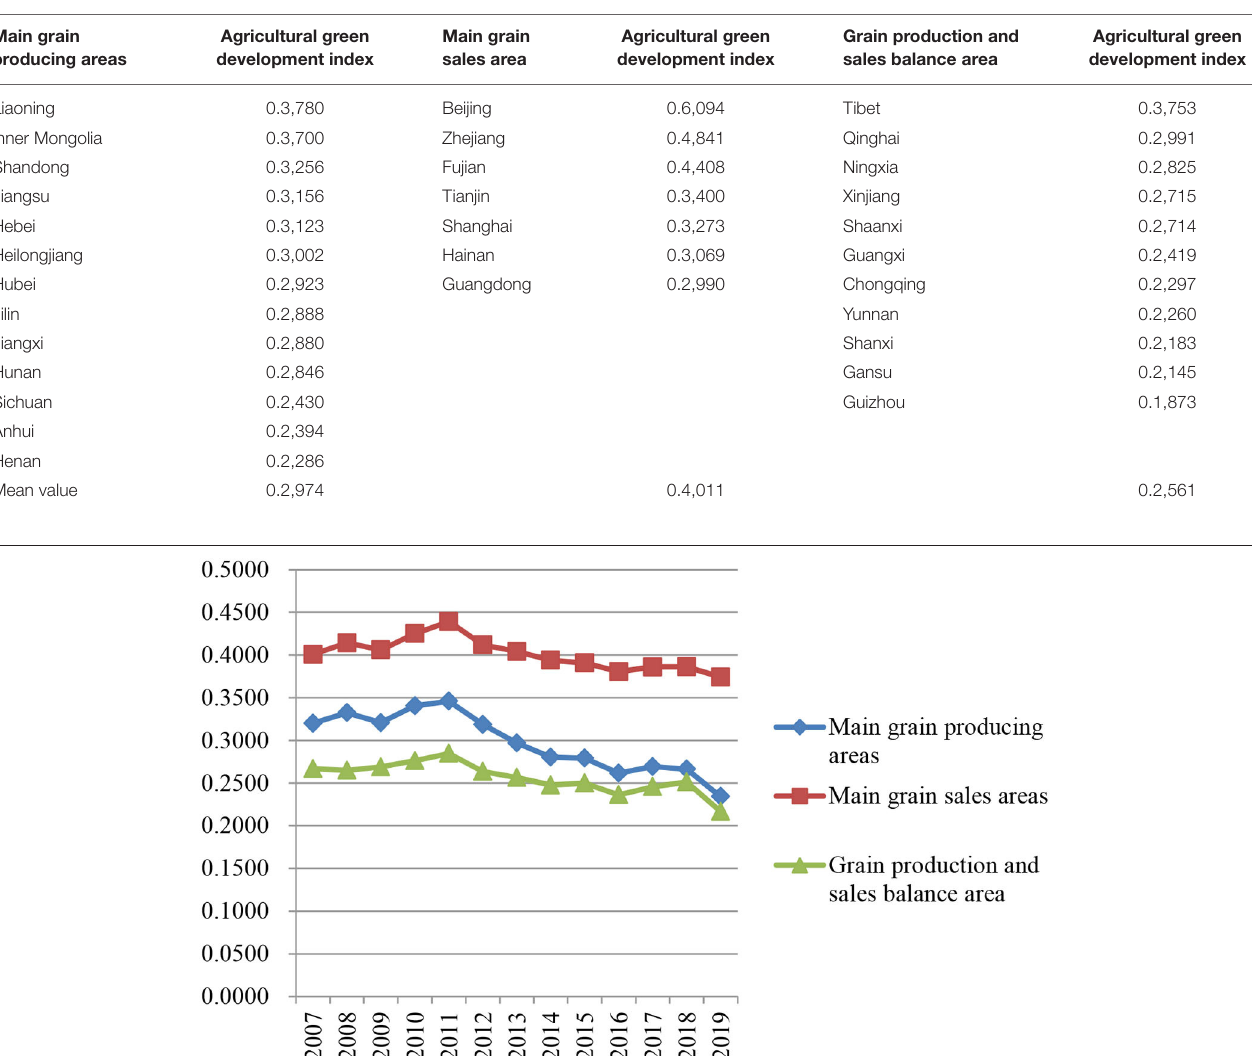
TABLE 4 | The average score of the agricultural green development index in all regions from 2007 to 2019.